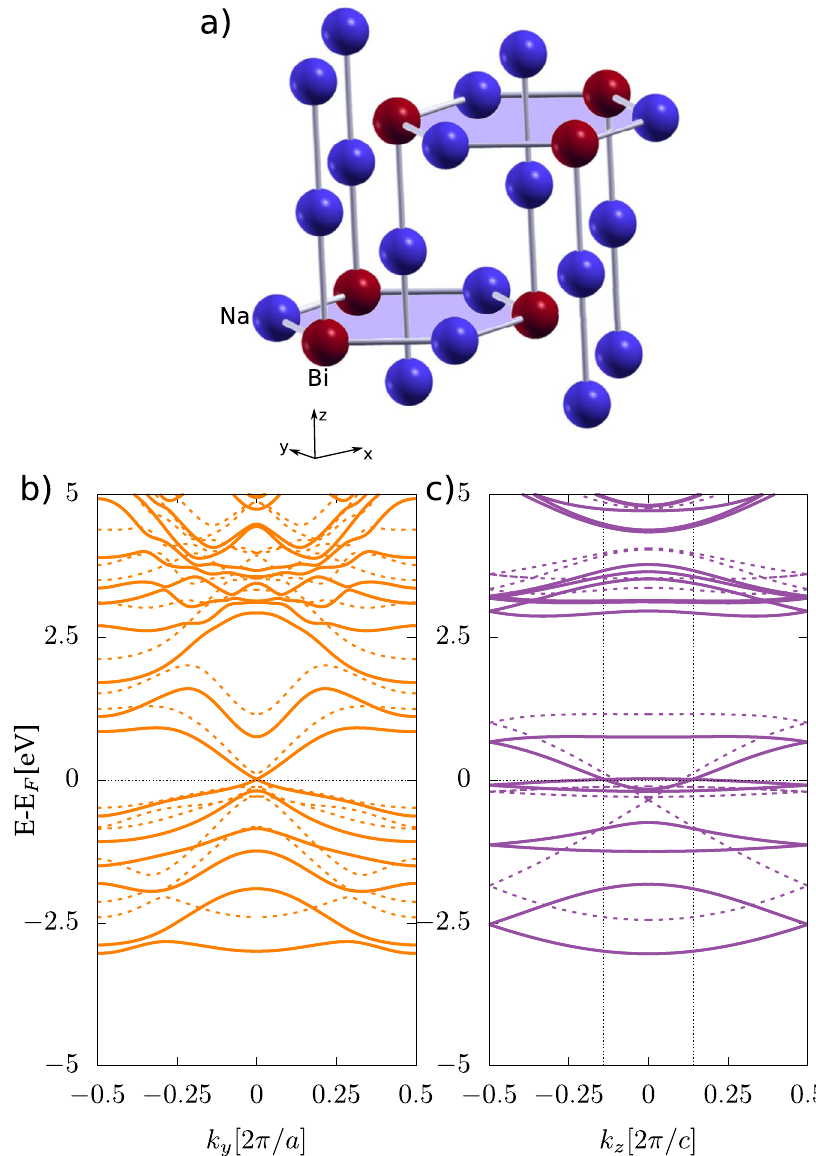
Fig. 1 Structural and electronic properties of Na 3 Bi. a Structure of bulk Na 3 Bi. b Band dispersion of Na 3 Bi along the k y direction, for k x = 0 and k z = 0.28 π / c , where c is the out-of-plane lattice parameter. c Band dispersion of Na 3 Bi along the k z direction, for k x = k y = 0. The vertical lines indicate the position of the two Weyl points. The dashed lines represent the bandstructure without